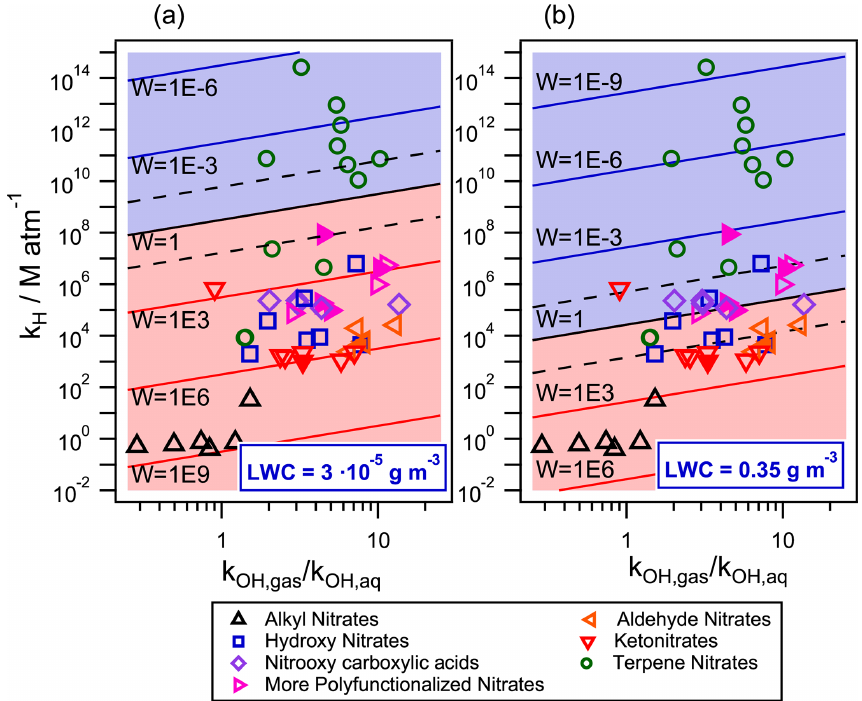
(cid:113) OH-oxidation) of 49 organic nitrates for two different air parcels with (cid:113) OH radical concen-